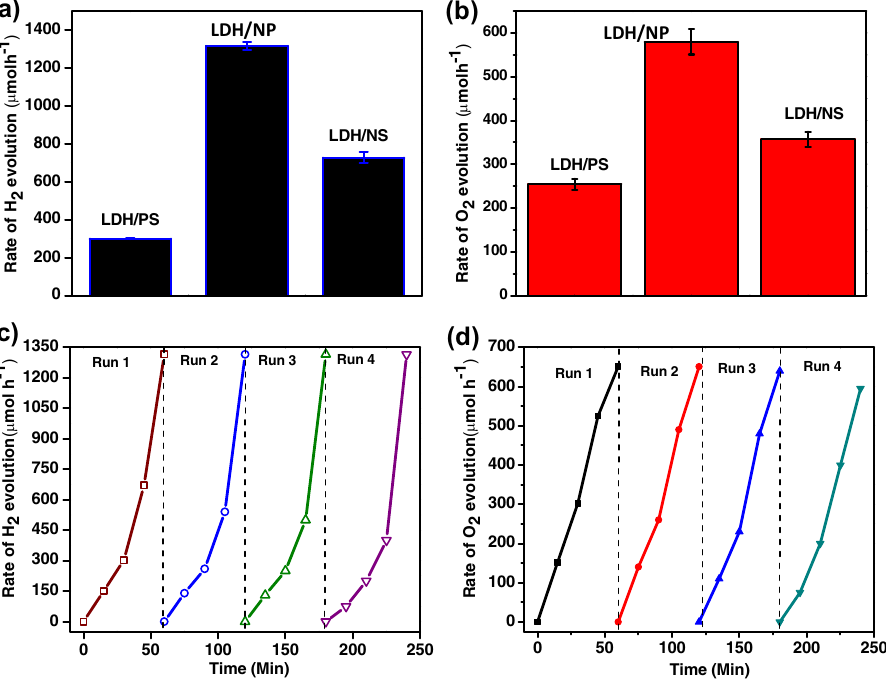
Figure 10. ( a , b ) Volume of H 2 and O 2 production plot under visible light illumination for 1 h; ( c , d ) Recyclability studies of MgCr-LDH/NP towards H 2 and O 2 evolution under visible light